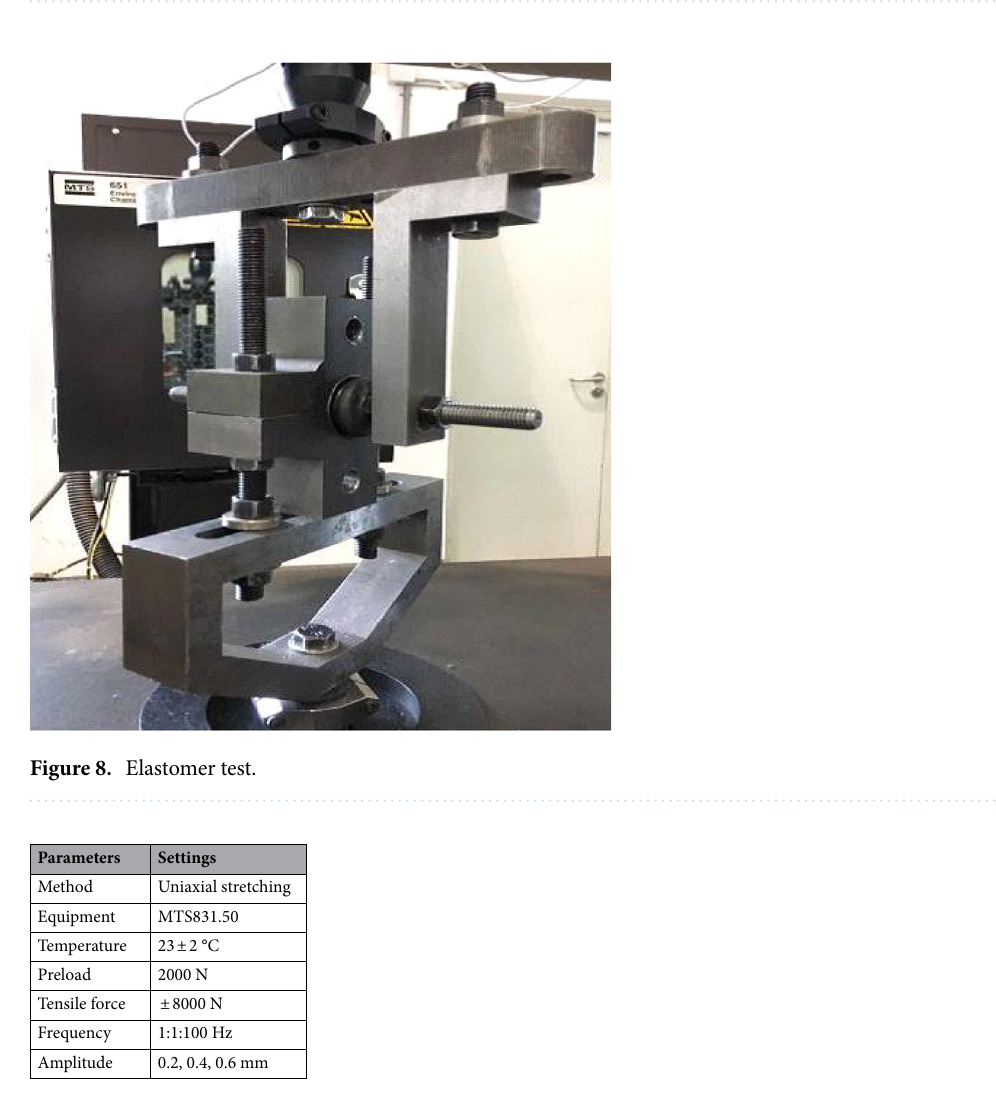
Figure 7. Relationship between torsional loss factor in x/y/z direction and frequency.